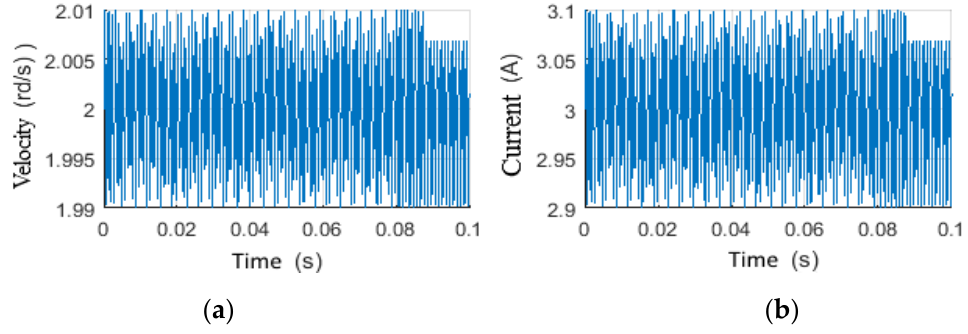
Figure 19. Test inputs of the observer for Scenario-5: ( a ) Top drive motor voltage, ( b ) Applied Weight on bit.